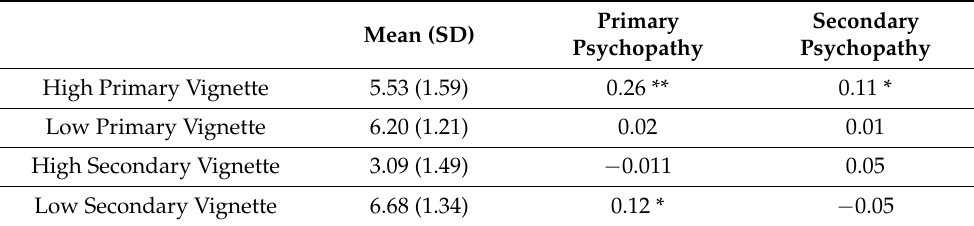
Table 2. Mean and SD of intelligence rating of vignettes, and correlations between vignette psychopa- thy and